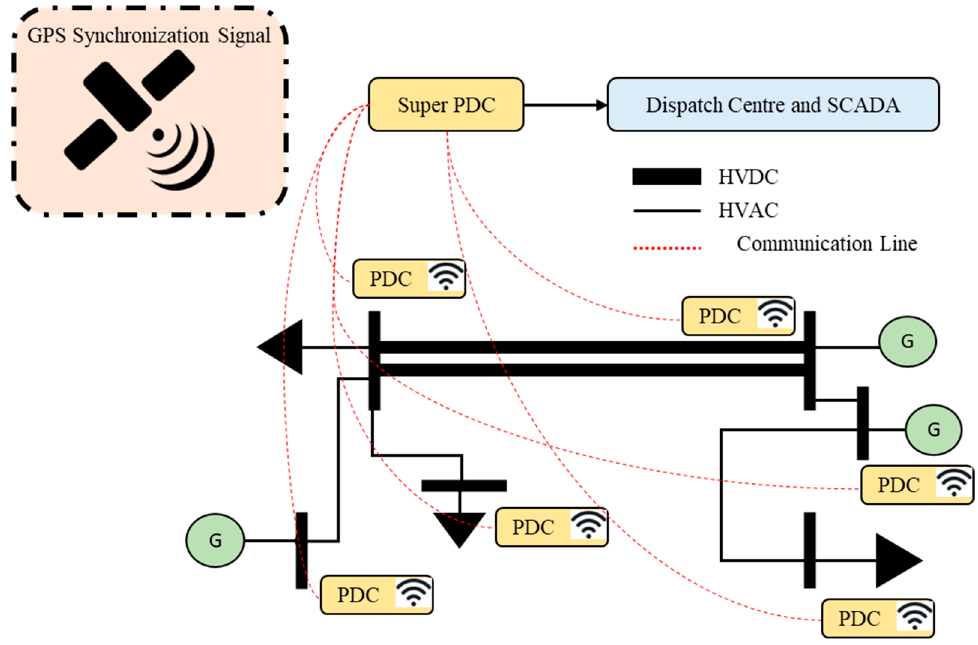
Figure 6. WAMPAC communication infrastructure.